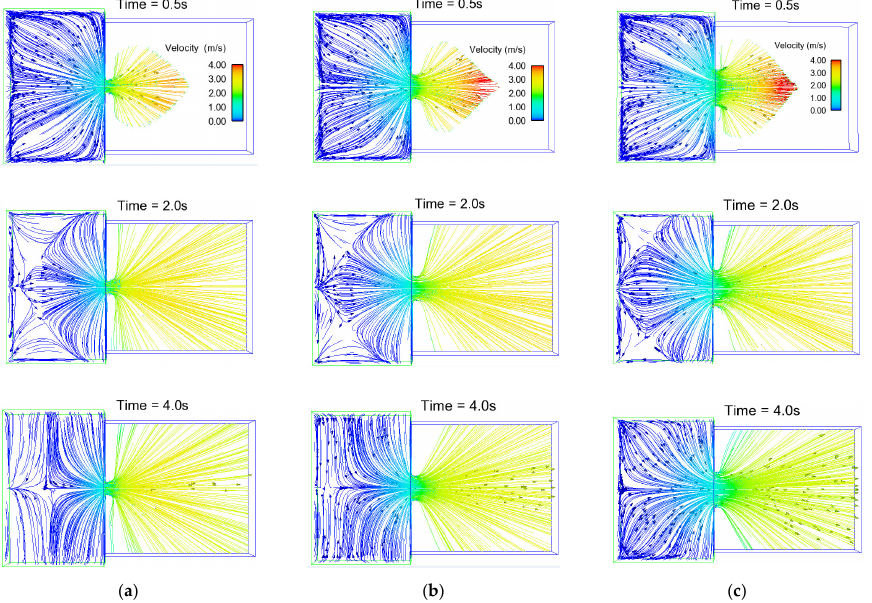
Figure 4. Streamline of magnitude velocity at different time in 3 models: ( a ) 7B, ( b ) 8B, ( c ) 9B.